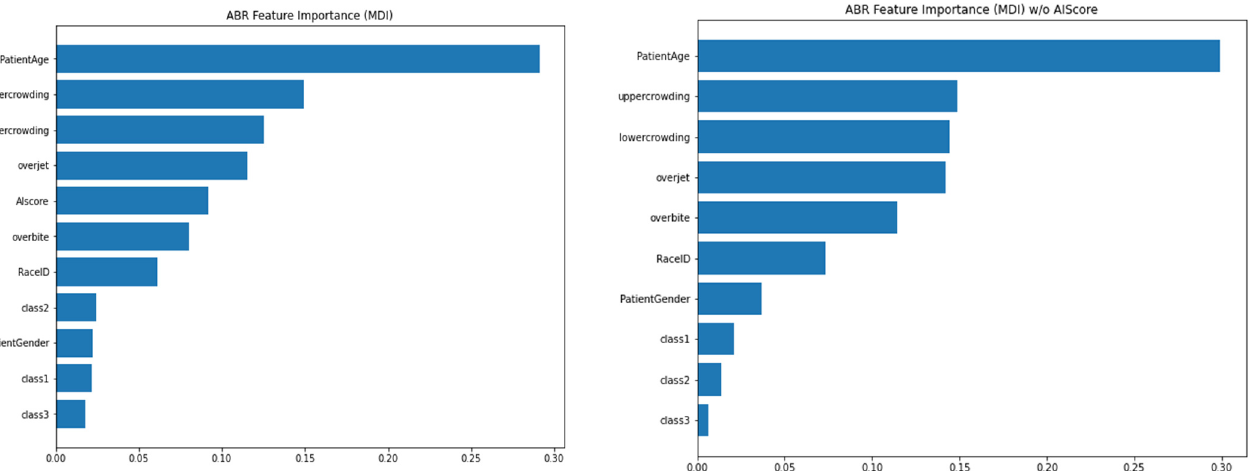
Figure 7. Permutation importance for the bagging model.